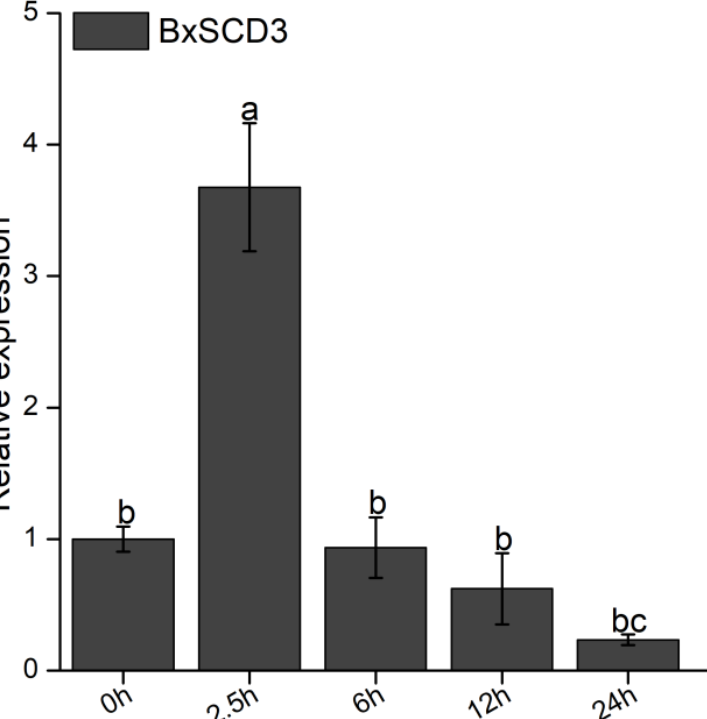
Figure 4. Relative transcript level of BxSCD3 in Bursaphelenchus xylophilus during the early stages of infection. Data are the means, and the error bars represent ± standard deviation from three biological replicates. Different letters on top of the bars indicate statistically significant differences ( p < 0.05, t ‐test) as measured by Duncan’s multiple range test.